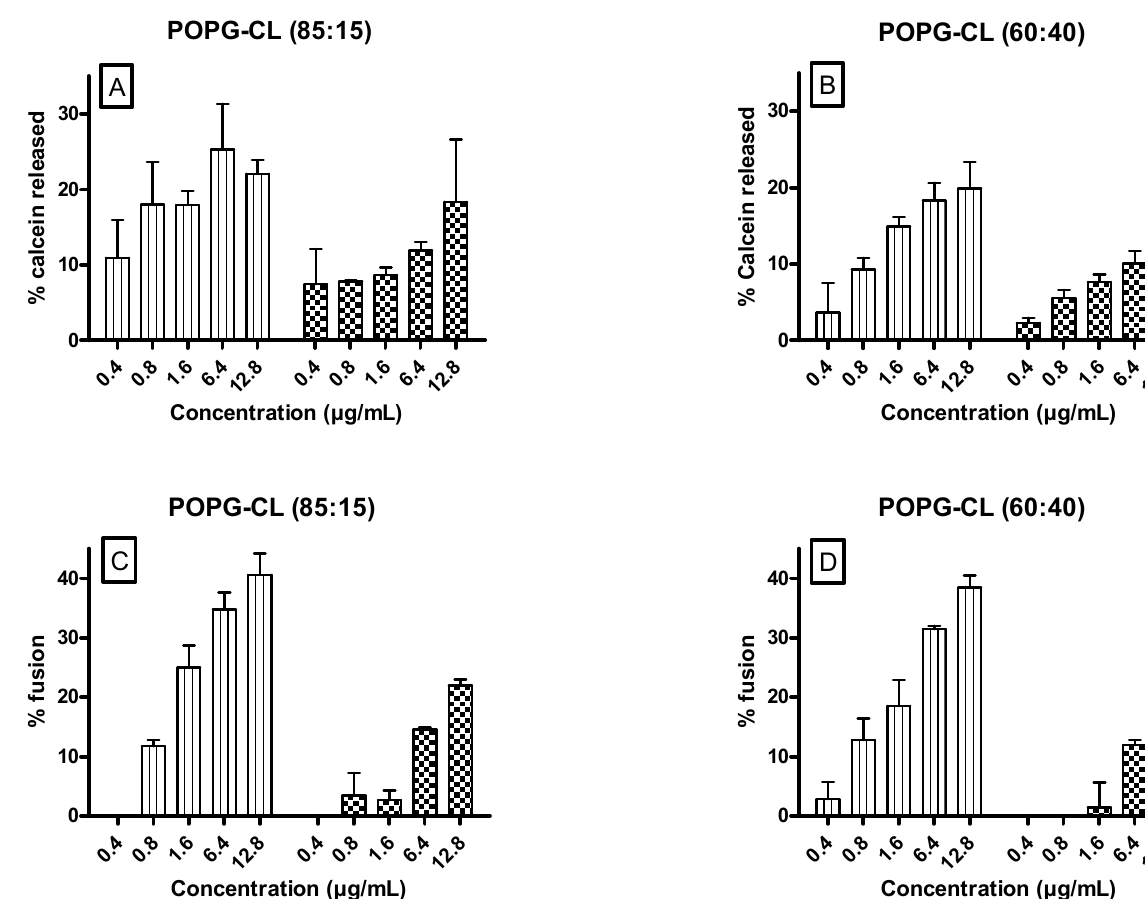
Figure 5. Effect of UA (Ursolic acid) (vertical lines) and OA (Oleanolic acid) (lattice) on calcein release ( A , B ) and relief of fluorescence self-quenching of R18s-labeled liposomes ( C , D ) in lipid vesicles (POPG:CL, 85:15 ( A , C ) or POPG:CL, 60:40 ( B , D ). The ordinate shows the percentage of calcein released ( A , B ) or the percentage of R18-fluorescence dequenching ( C , D ) compared to what was observed after addition of 2% Triton X-100 (positive control, considered as 100%). Data (SEM) are representative of three independent experiments in triplicate. Significant differences were observed when comparing the effect induced by UA and OA. POPG (1-Palmitoyl-2-oleoyl- sn -glycero-3-phosphoglycerol), CL (cardiolipin).